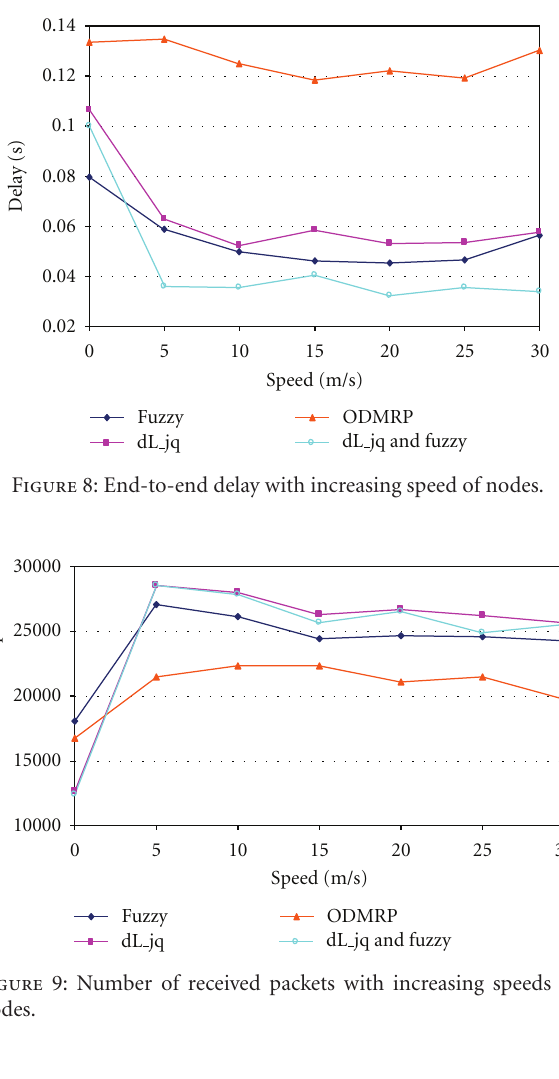
Figure 7: Life time.